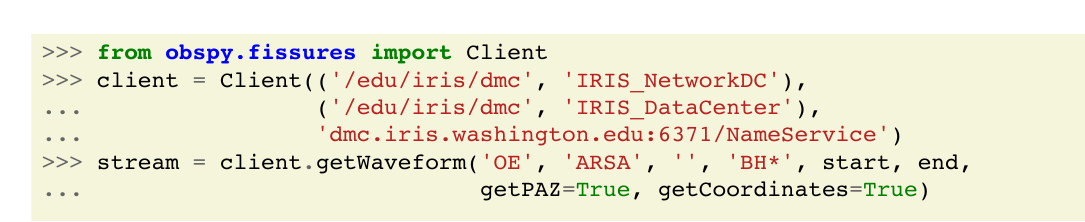
Figure 8. Example code: Retrieving data from a Fissures server.